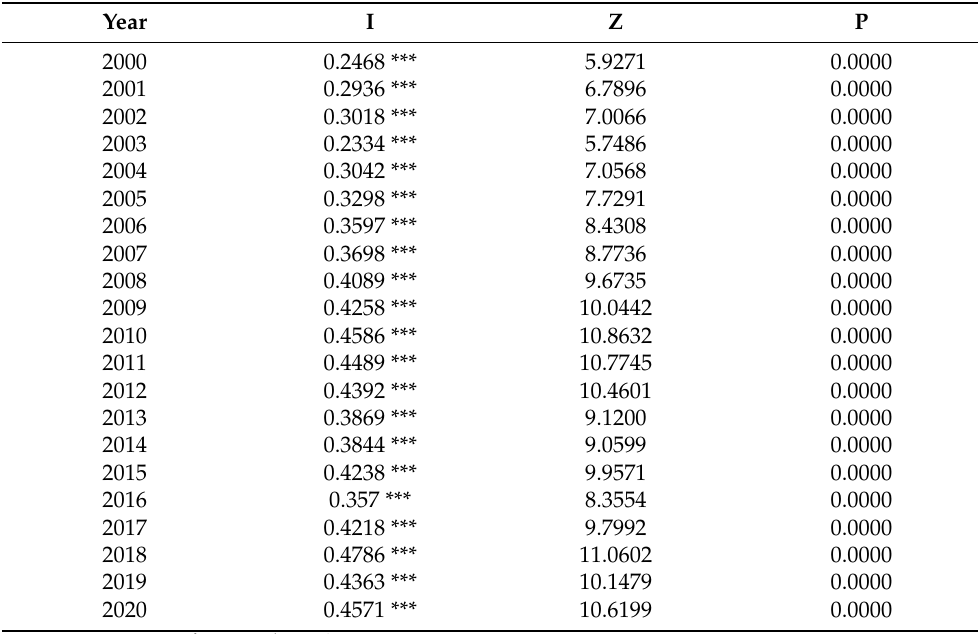
Table 2. Moran’s I index test results from 2000 to